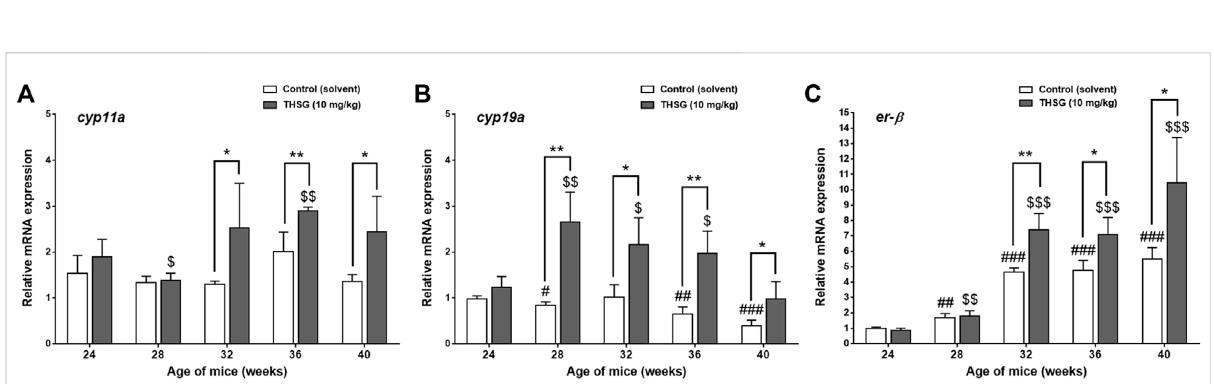
FIGURE 9 THSG affects gene expression of steroidogenic enzymes and er- β in aged mice groups. Mice fed with THSG or untreated controls were sacri fi cedattheendof24,28,32,36,and40 weeksofage.OvarieswereharvestedandtotalRNAwasextracted.qPCRwasconductedfor cyp11a (A) , cyp19a (B) , and er- β (C) . The number of independentstudies ( n )= 4. Resultswere expressed as themean ± SD; * p < 0.05, ** p < 0.01, compared with eachage-matchedcontrolgroup;# p < 0.05,## p < 0.01,### p < 0.001,comparedwiththecontrolgroupof24-week-oldmice;$ p < 0.05,$$ p < 0.01, $$$ p < 0.001, compared with the THSG-treated group of 24-week-old